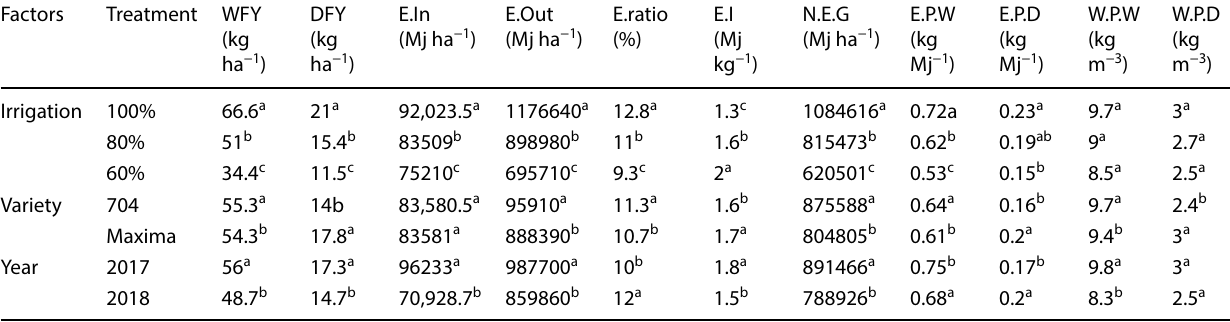
Mean with the same letter(s) is not significantly different using Duncan’s multiple range tests ( P ≤ 0.05) WFY: wet forage yield, DFY: dried fodder yield, E.In: input energy, E. Out: output energy, E.ratio: energy ratio, E.I: energy intensity, E.N.G: net energy gain, E.P.W: energy productivity of wet forage yield, E.P.D: energy productivity of dried fodder yield, W.P.W: water productivity of wet forage yield, W.P.D: water productivity of dried fodder Table 6 Mean comparison of interaction between irrigation levels and variety of maize for some biochemical